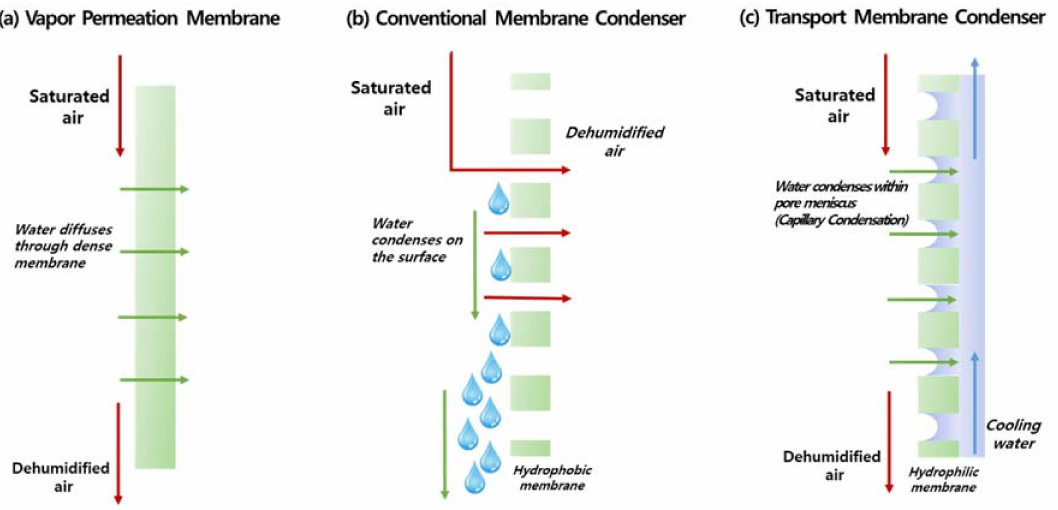
Figure 3. Different types of membrane-based water dehydration: ( a ) vapor permeation using a dense membrane, ( b ) con- ventional membrane condenser configuration using a hydrophobic microporous membrane to condense the water vapor on the surface, ( c ) transport membrane condenser using a nanoporous membrane to selectively condense water vapor within capillary pores. (Reprinted with permission from